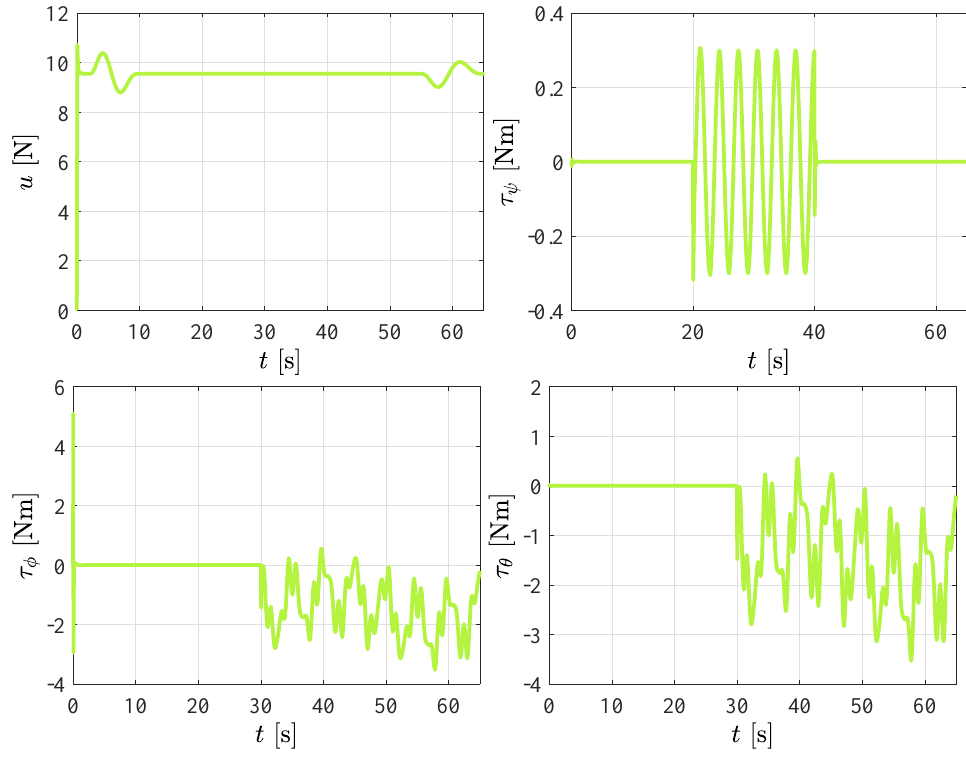
Figure 17. Computed control inputs in experiment